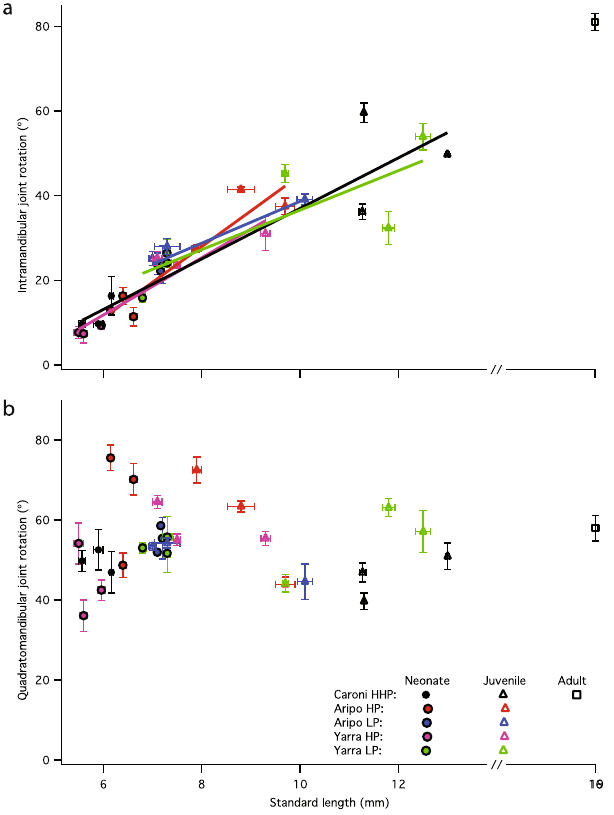
Figure 5. Intramandibular and quadratomandibular joint rotation in relation to body length in neonates and juveniles. Intramandibular joint rotation ( a ) increases with size among neonates and throughout ontogeny, but quadratomandibular joint rotation ( b ) does not change with size. Five populations and two age classes are presented (neonates indicated by closed symbols; juveniles indicated by open triangles; one adult indicated by open square for reference). Each data point shows mean brood joint rotation and mean standard length + standard error for 5–6 scraping events per brood. Regression lines in A are distinct from linear mixed model reported in